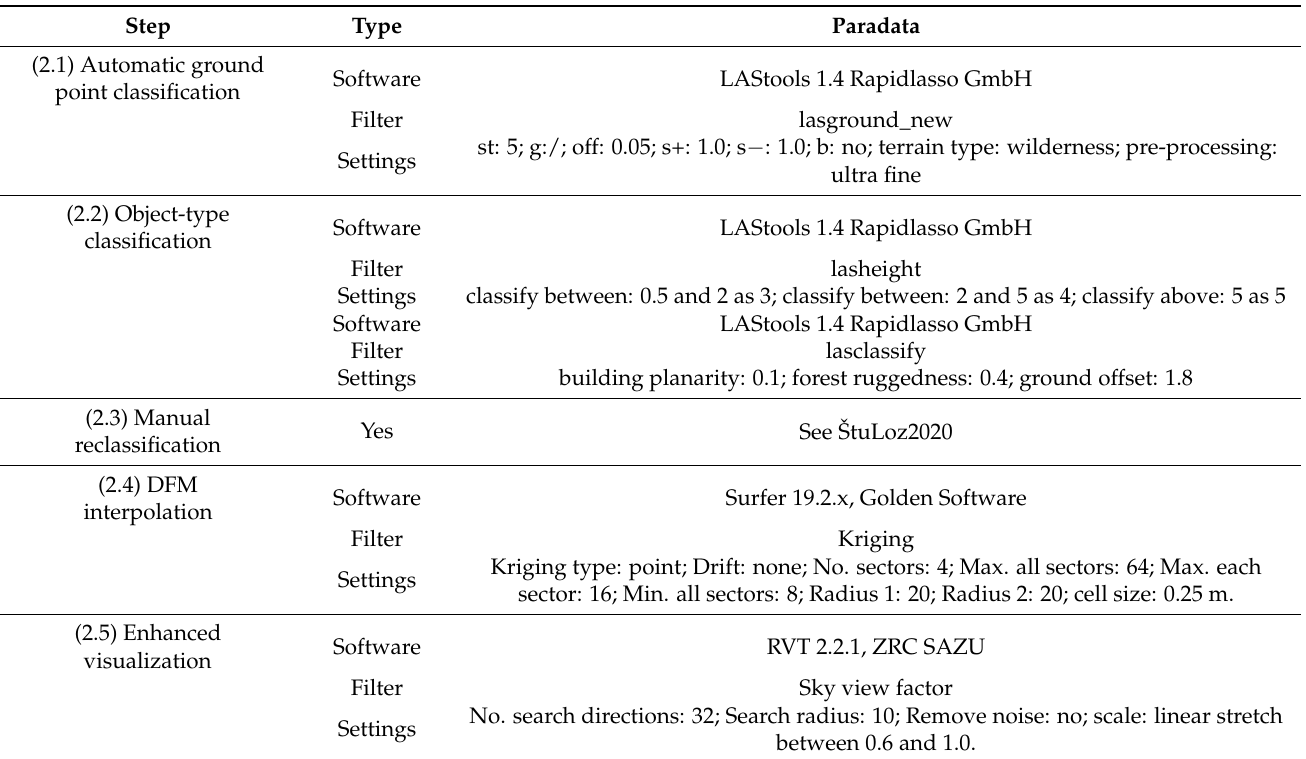
Table 3. Paradata for conventional point cloud processing and derivation of products to which the proposed pipeline has been compared (paradata structure after